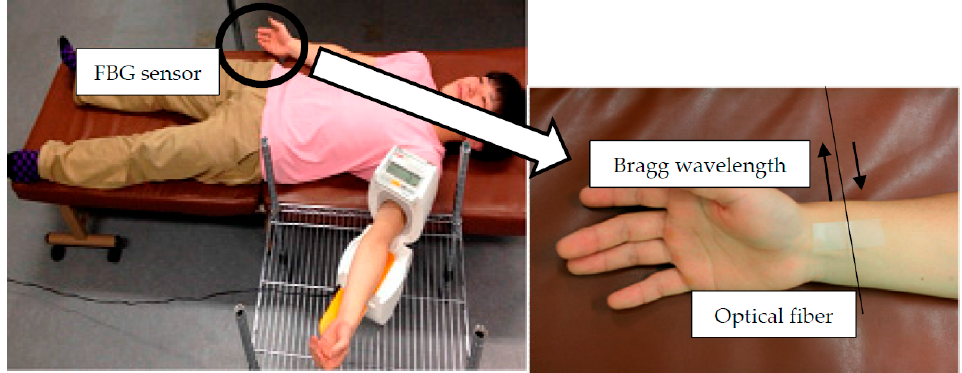
Figure 3. Experimental image of blood pressure measurement by the FBG sensor.